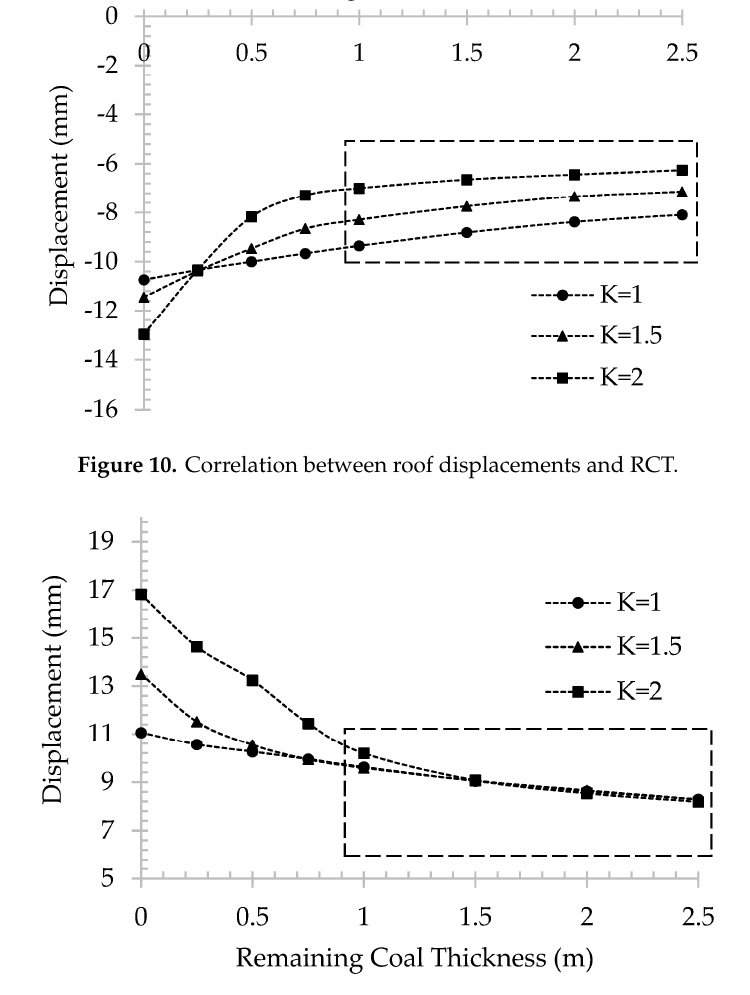
Figure 11. Correlation between floor displacements and RCT.